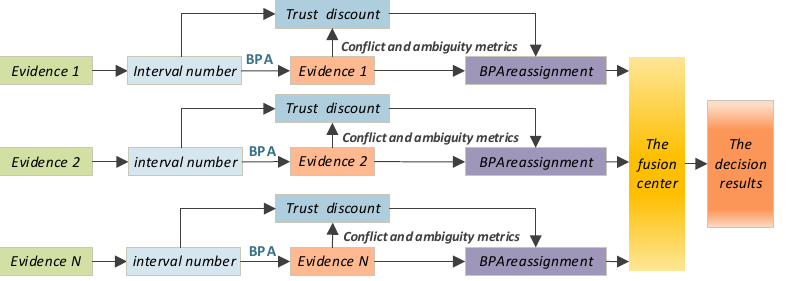
Figure 1. Multi-sensor data fusion model.